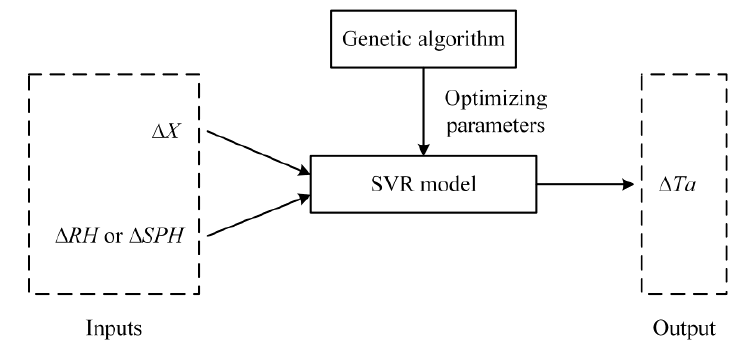
Figure 3. Framework of the genetic support vector regression.